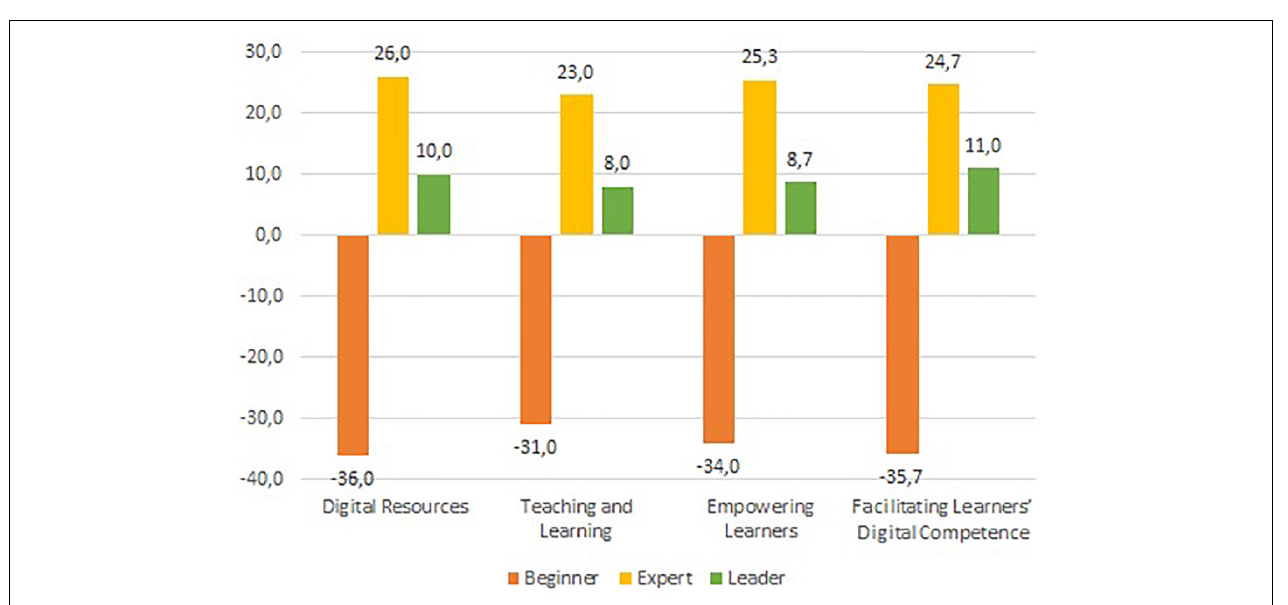
FIGURE 2 | Dynamics of Case 2 participants’ digital competences (increase in competence-level group sizes, by DigCompEdu area, in percentage points).